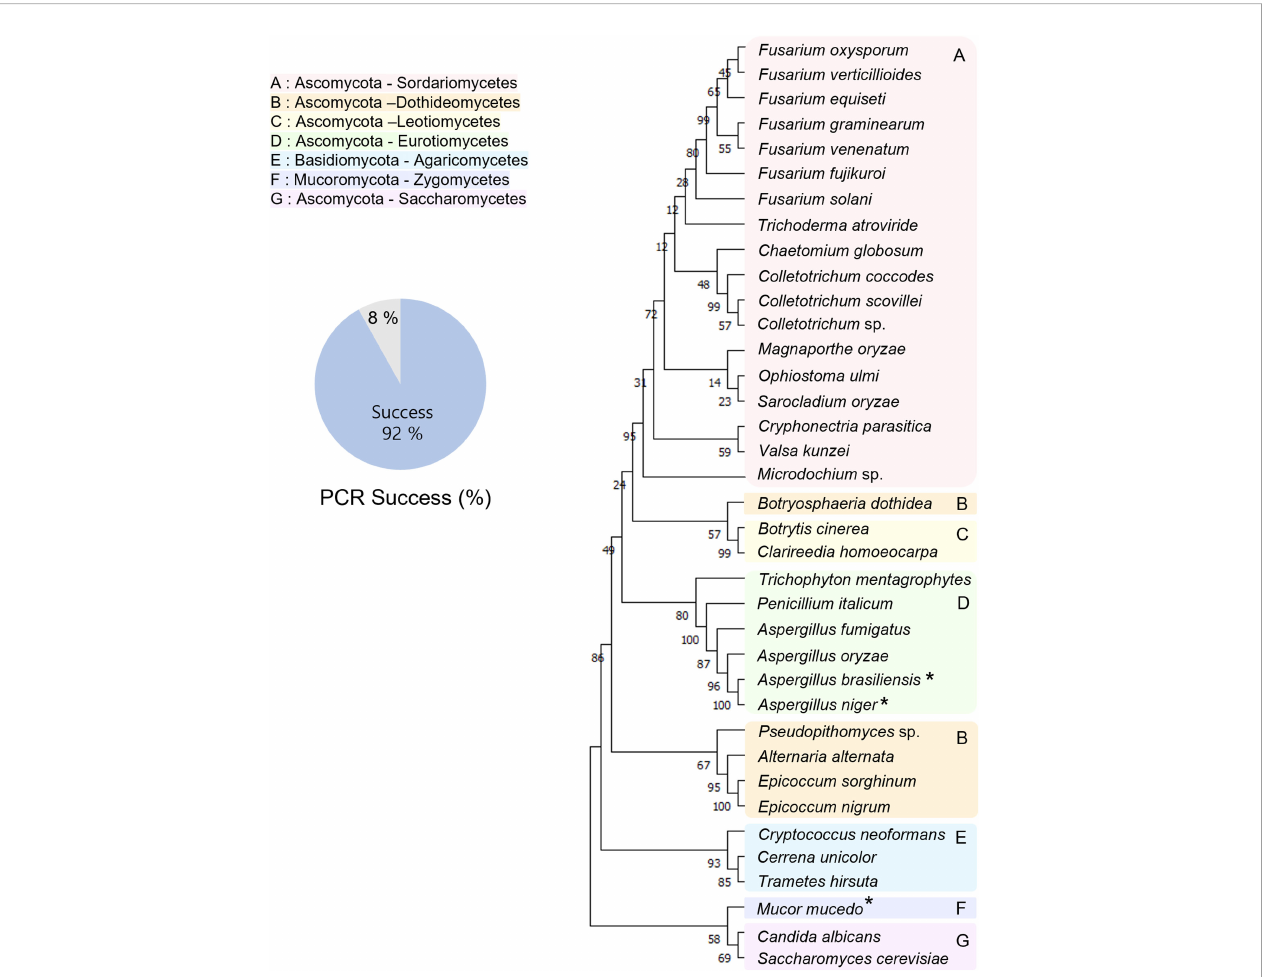
FIGURE 2 Phylogenetic tree of representatives of major fungal lineages. The tree is inferred from ITS sequences obtained by the direct PCR approach. The asterisks indicate that the sequences of these strains were obtained by the conventional PCR method involving genomic DNA extraction steps. The representatives of the major fungal lineages are clustered by the classes. A pie chart indicating the PCR success rate shows that the direct PCR approach is reliable and applicable. A : Sordariomycetes, B : Dothideomycetes, C : Leotiomycetes, D : Eurotiomycetes, E : Agaricomycetes, F : Zygomycetes, G : Saccharomycetes. Species of the same color indicate they are in the same